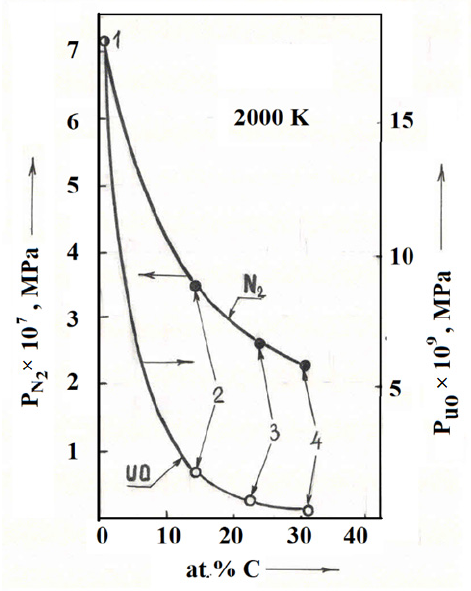
Figure 5. Change in the partial pressures of N 2 and UO over uranium-zirconium carbonitrides depending on the carbon content at a temperature of 2000 K, in comparison with the data on uranium mononitride [21]. 1—UN [21], 2—composition No. 13 (this work), 3—composition No. 14 (this work), 4—composition No. 15 (this work) (Table